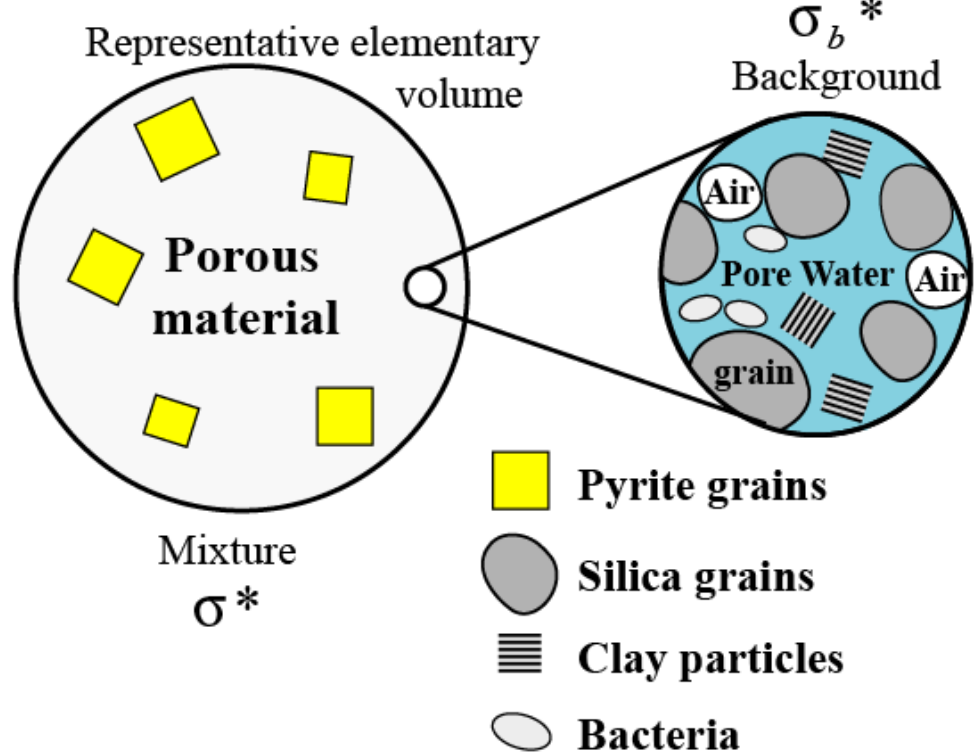
Figure 4. Sketch of the complex background and the mixture between the background and the metallic particles (with metallic grains, for instance, pyrite). The background material can be partially saturated (with air as a nonwetting immiscible fluid) at a partial saturation. It can comprise various types of grains. Polarizable bacteria can be present in the pore space. The quantities σ * and σ b * denote the complex conductivity of the mixture and the complex conductivity of the background material around the metallic particles, respectively.